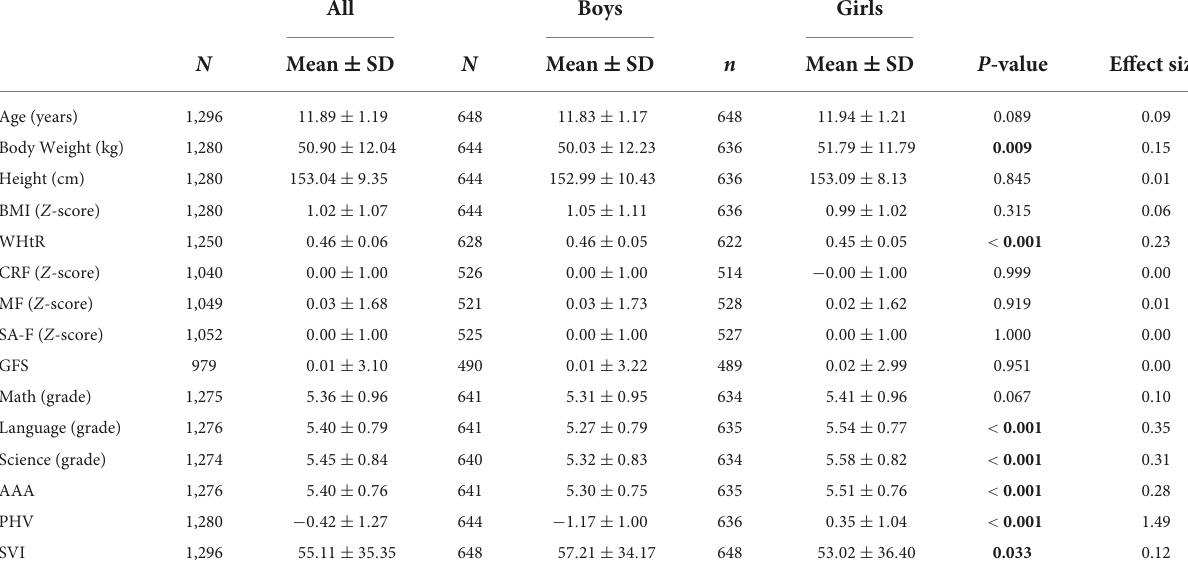
TABLE 1 Participant characteristics by sex.